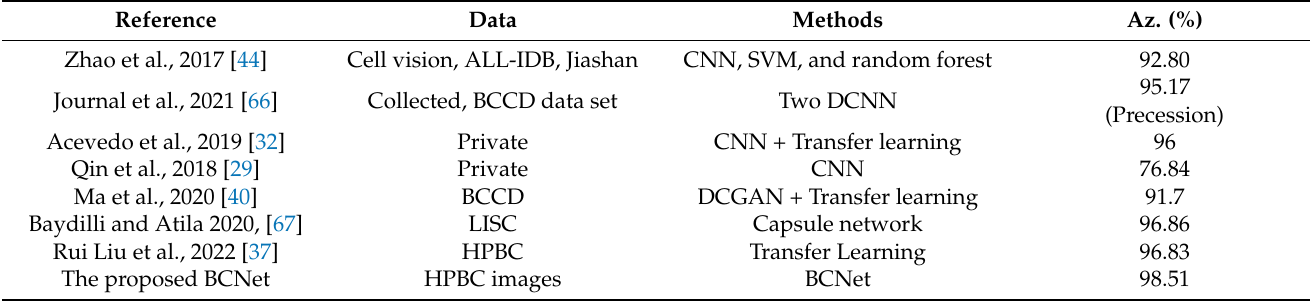
Table 4. Evaluation comparison results for blood cell identification via the proposed BCNet against the latest deep learning works in the literature.